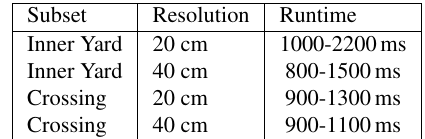
Table 3. The runtime for the Inner Yard and Crossing subset, determined with different voxel